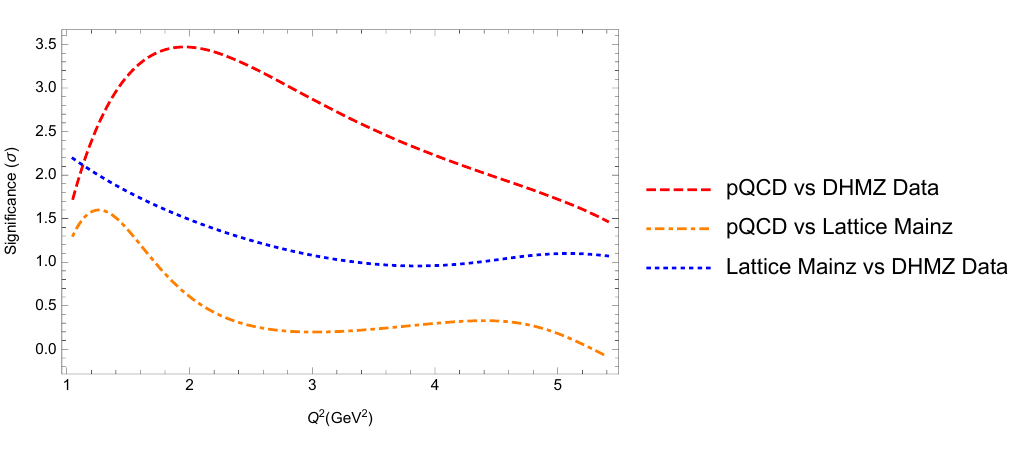
Figure 15 . Comparison between the Adler functions obtained from pQCD, the DHMZ compilation of e + e − data and the lattice results of ref. [14].